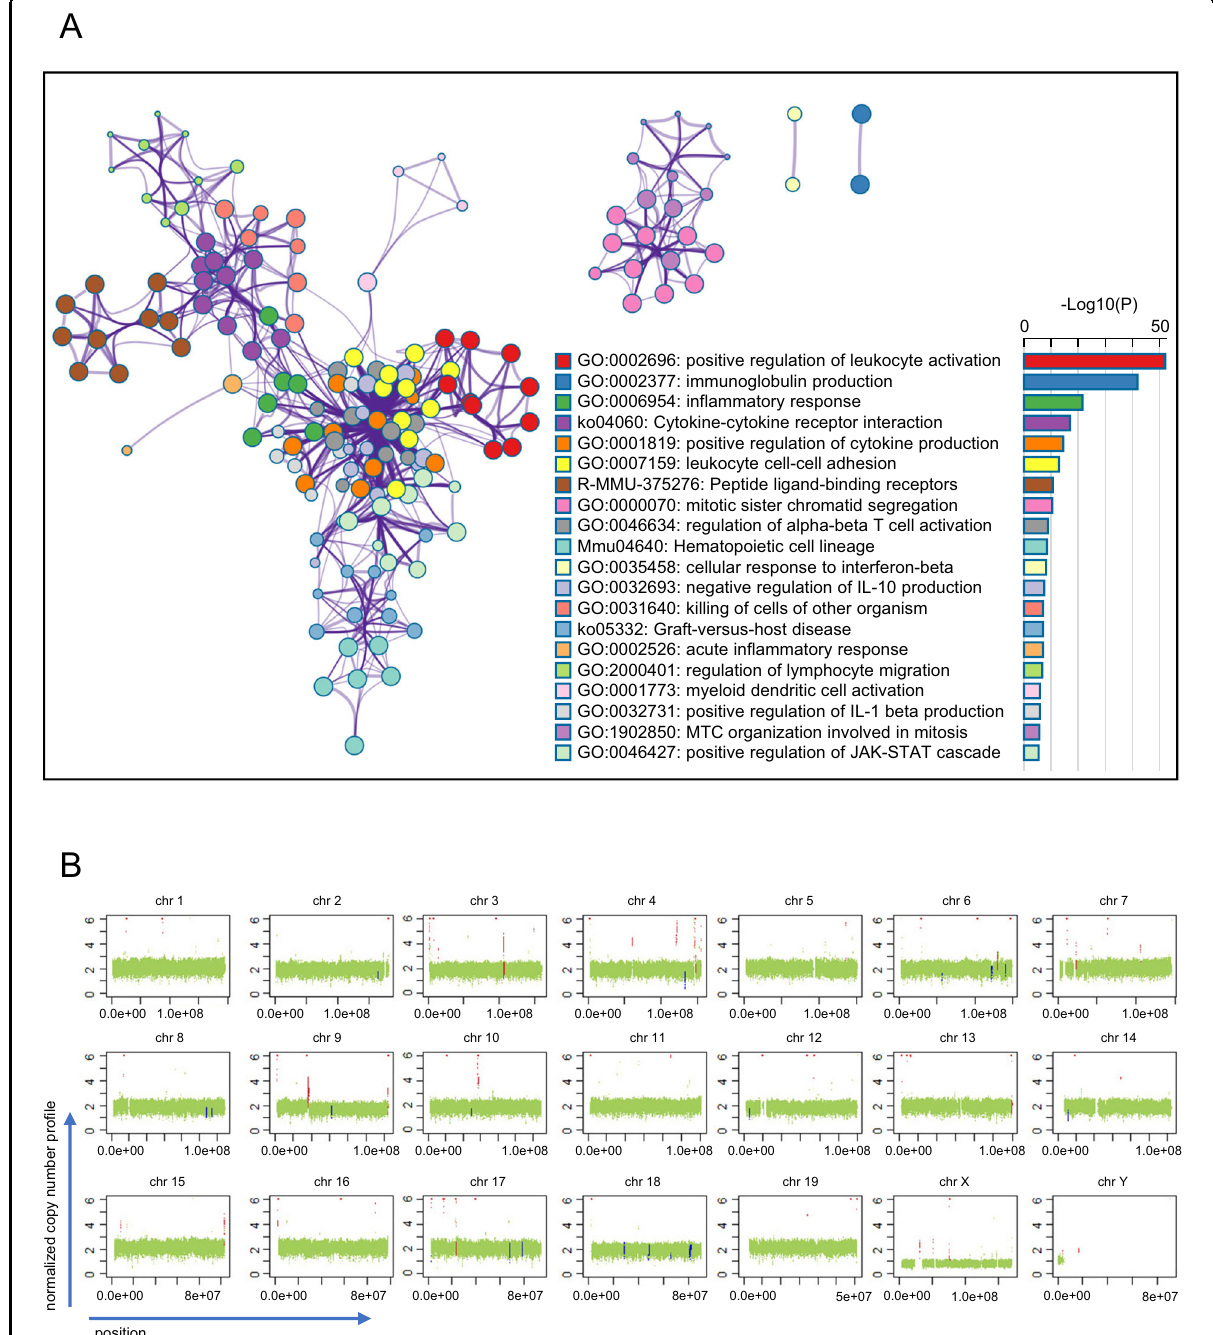
Fig. 4 Gene expression pro fi les and genetic instability of induced gall bladder (GB) cancers. A RNA-seq analysis using the orthotopic GB cancer tissues, GBCa-#1, #2, and #3, and normal GB tissues, GB-#1, #2, #3. The network layout of pathway enrichment analysis is shown. The size of each circle node is proportional to the number of input genes that fall under that term. Terms with a similarity score >0.3 are linked by an edge. Top 20 statistically enriched terms are shown with their p value. Log10(P), the p value in log base 10. MTC microtubule cytoskeleton. IL interleukin. B Summary of genome instability. Gene copy number alteration was calculated based on whole-genome analysis of GBCa-#1 is shown. Green, red and blue dots indicate base line, gain, and loss, respectively. Chr